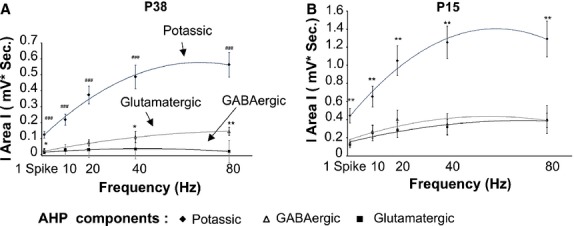
The area of the potassium component of the AHP predominates over the areas of the synaptic components. The absolute value of the areas of the different AHP components is depicted as a function of the MC firing rate. (A) P38 group; note that the potassium and the glutamatergic components but not the GABAergic component increase with the firing frequency (P < 0.001, Friedman). (B) P15 group, all component increases with the MC firing rate (P < 0.001, Friedman). *Significant difference between the glutamatergic and GABAergic components. #Significant difference between the potassium and the synaptic components. *P < 0.05; **P < 0.01; ###P < 0.001.